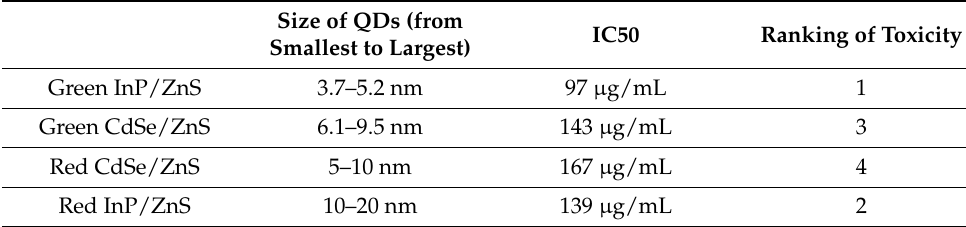
Table 1. IC50 values and ranking of toxicity of green and red CdSe/ZnS and InP/ZnS QDs in Hela cells. Size of QDs (from IC50 Ranking of Toxicity Smallest to Largest) Green InP/ZnS 3.7–5.2 nm 97 µ g/mL 1 Green CdSe/ZnS 6.1–9.5 nm 143 µ g/mL Red CdSe/ZnS 5–10 nm 167 µ g/mL Red InP/ZnS 10–20 nm 139 µ